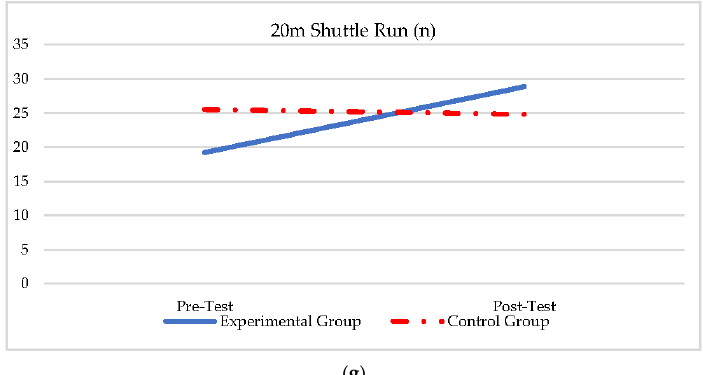
Figure 3. ( a – g ). Group interaction over time regarding physical fitness skills. ( a ) Group × Time effect during pre- and post-test ( f = 88.98; p = ≤ 0.001); ( b ) Group × Time effect during pre- and post-test ( f = 83.97; p = ≤ 0.001); ( c ) Group × Time effect during pre- and post-test ( f = 0.52; p = 0.473); ( d ) Group × Time effect during pre- and post-test ( f = 32.19; p = ≤ 0.001); ( e ) Group × Time effect during pre- and post-test ( f = 18.73; p = ≤ 0.001); ( f ) Group × Time effect during pre- and post-test ( f = 60.22; p = ≤ 0.001); ( g ) Group × Time effect during pre- and post-test ( f = 381.40; p = ≤ 0.001).